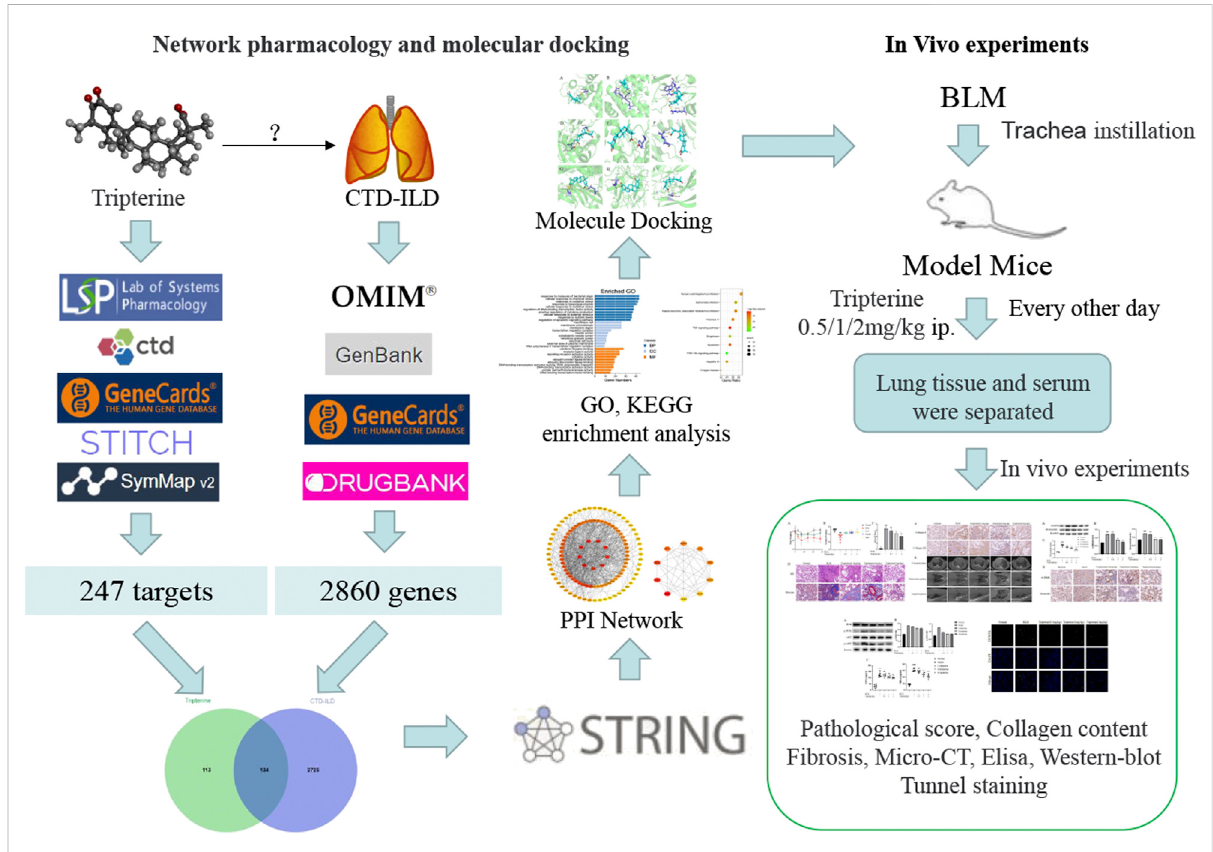
FIGURE 1 Work fl ow of the network pharmacology analysis and experimental veri fi cation in this